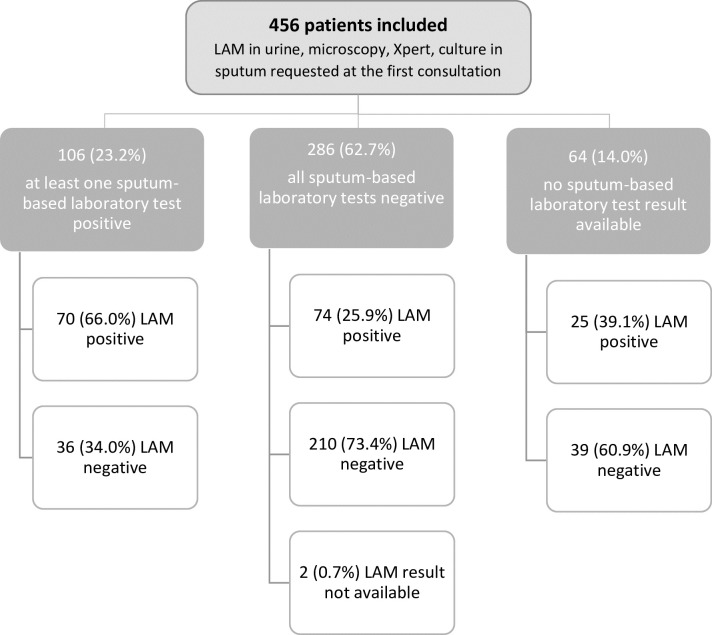
Patient flow and TB diagnostic test results.LAM, lipoarabinomannan assay; TB, tuberculosis; Xpert, Xpert MTB/RIF assay.